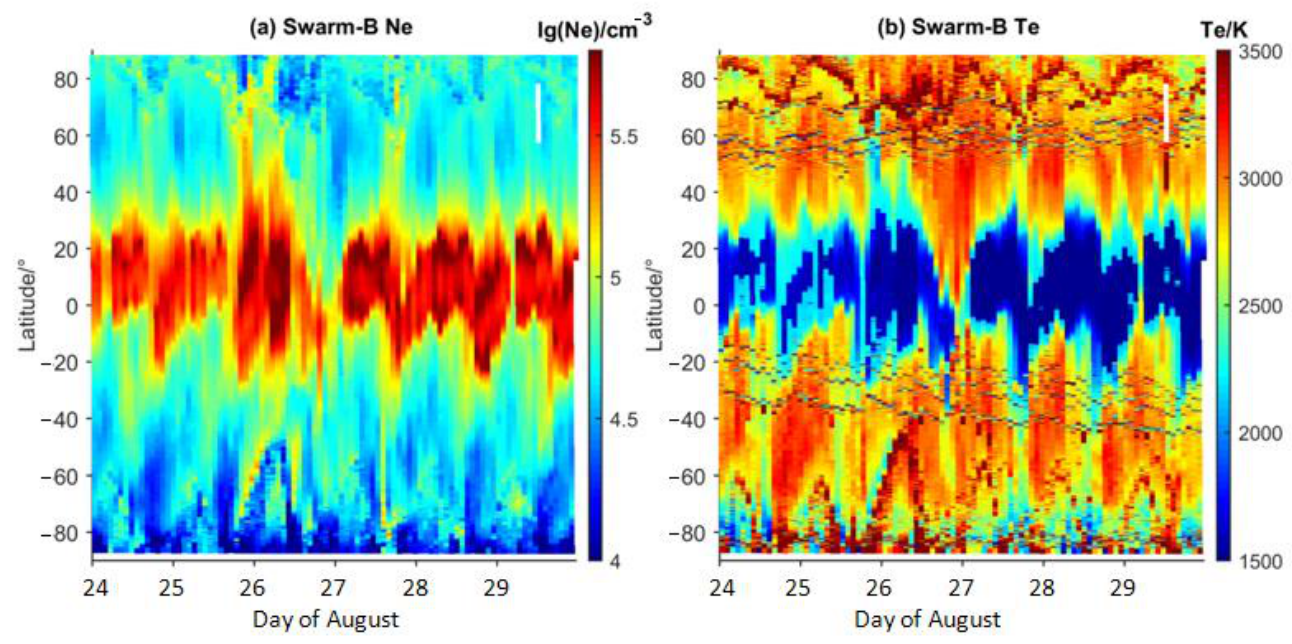
Figure 6. The electron density ( a ) and electron temperature ( b ) from Swarm-A in local daytime during 24 to 29 August in 2018.